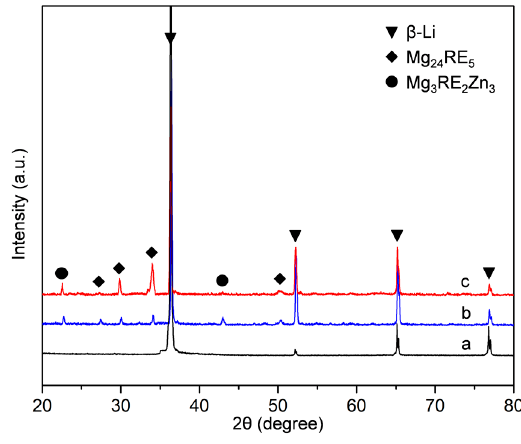
Figure 5. XRD patterns of the as-extruded alloys: ( a ) Mg-11Li, ( b ) Mg-11Li-4Y-2Er-2Zn, and ( c ) Mg-11Li-8Y-4Er-4Zn.